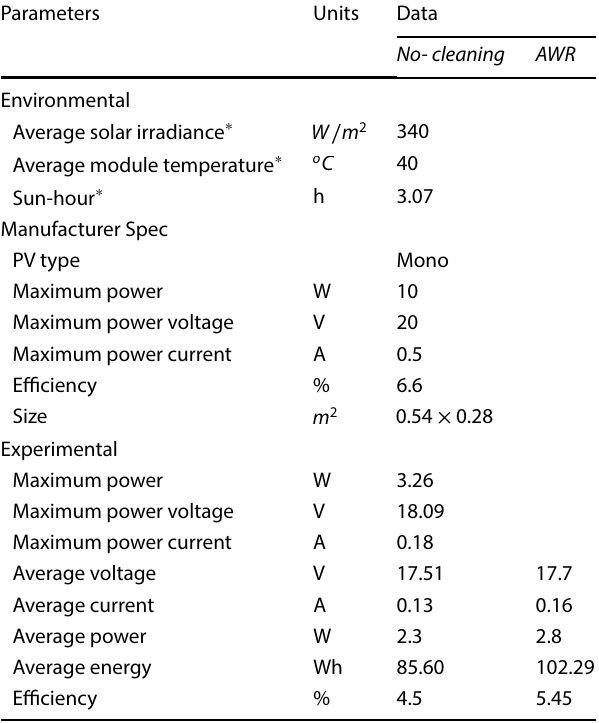
Table 3 Comparative analysis among manufacturer specification, experimental data, and other researchers’ outcomes based on environmental and electrical parameters of no-cleaning and AWR- based PV